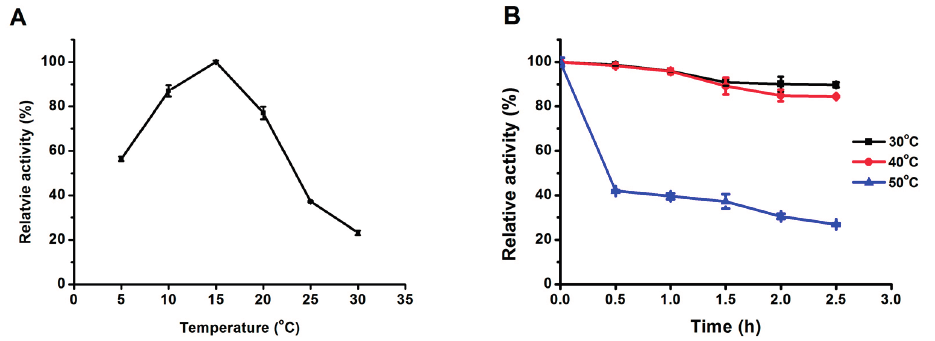
Figure 3. Effect of temperature on activity ( A ); and stability ( B ) of Mg MDL2. ( A ) The